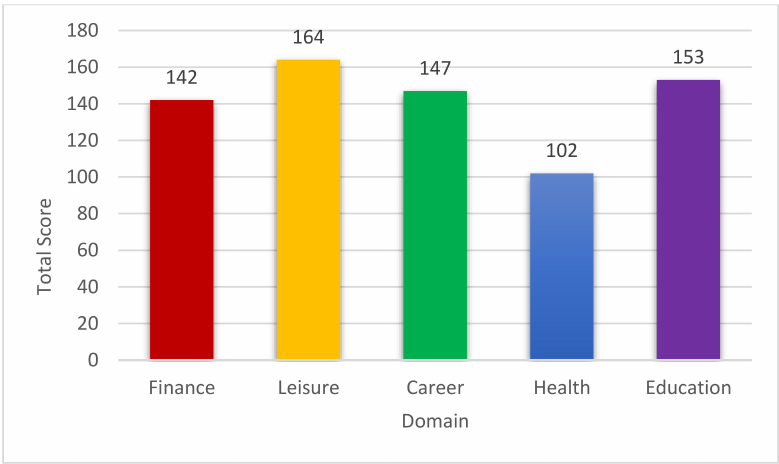
Figure 2. Risk rating by